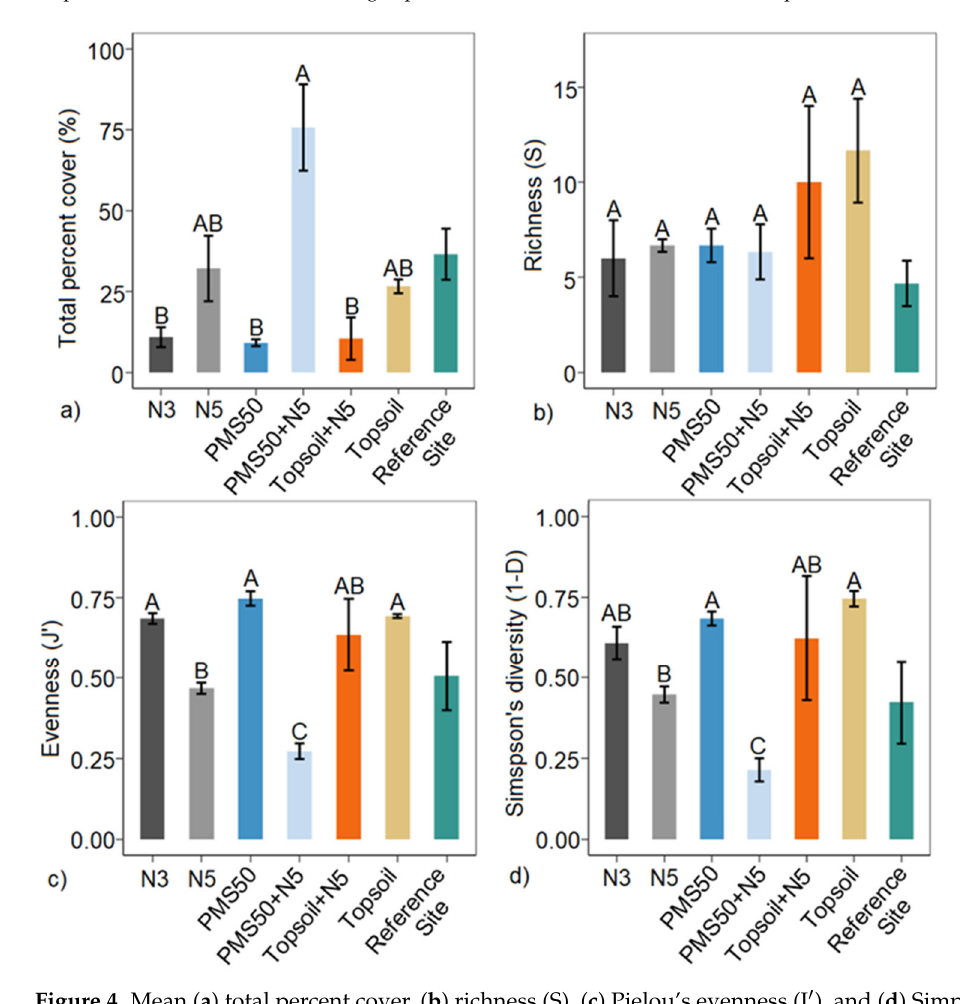
Table 6. Summary of PERMANOVA of the effect of amendment application (N3, N5, PMS50,